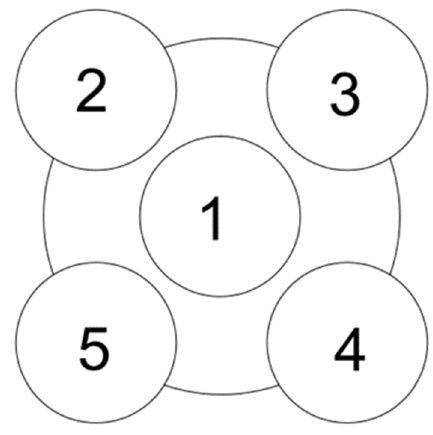
Figure 3. Calibration method of PQI 380.